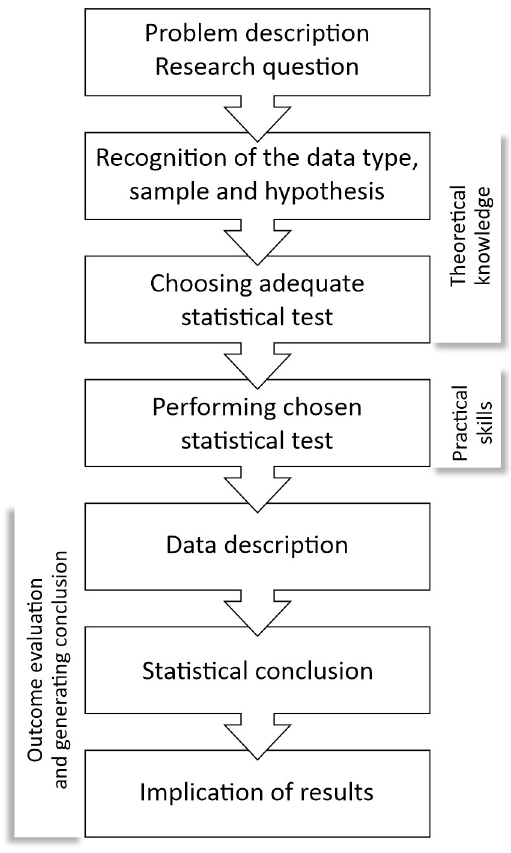
Fig 1. Basic structure of statistical analysis and the problem-based